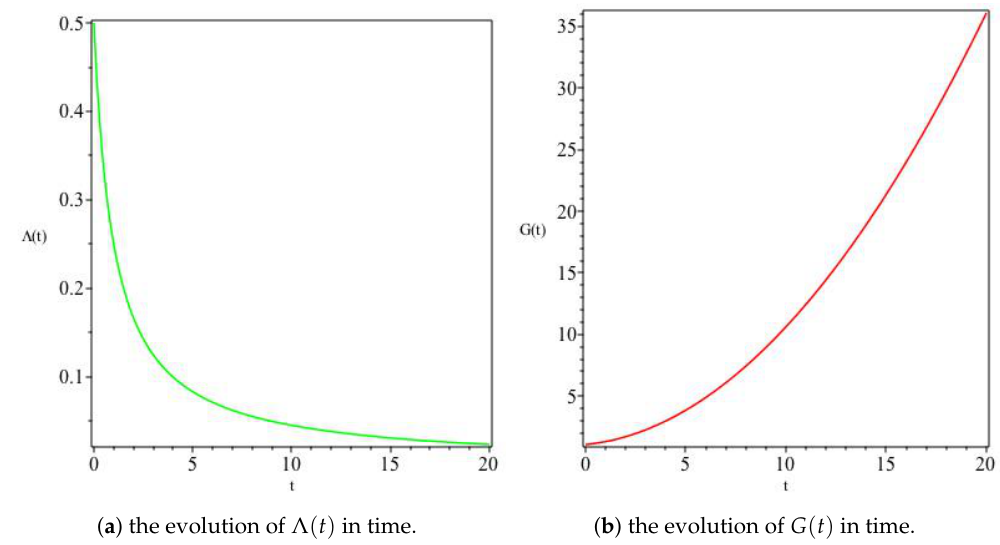
Figure 3. The variation of Λ and G for α = − 2 , β = 1. For this model, we see a monotonically decreasing Λ in Panel ( a ), whereas Panel ( b ) shows an increasing G with time.